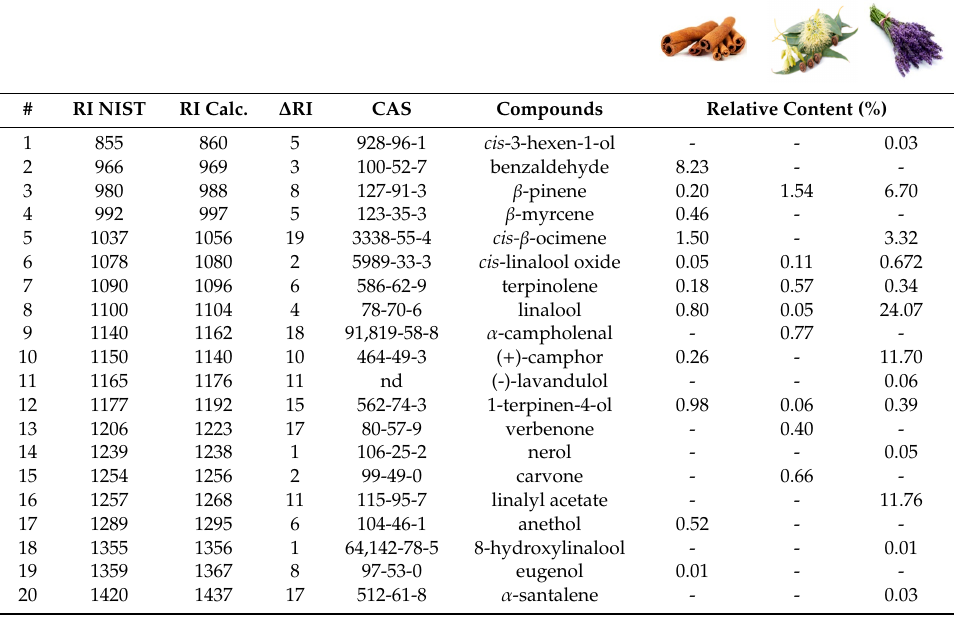
Table 1. Antennal active volatile compounds with their relative content in the three EOs’ headspace. RI NIST: retention index obtained from NIST database, RI Calc.: calculated RI, Δ RI: absolute difference of RI NIST and RI Calc.